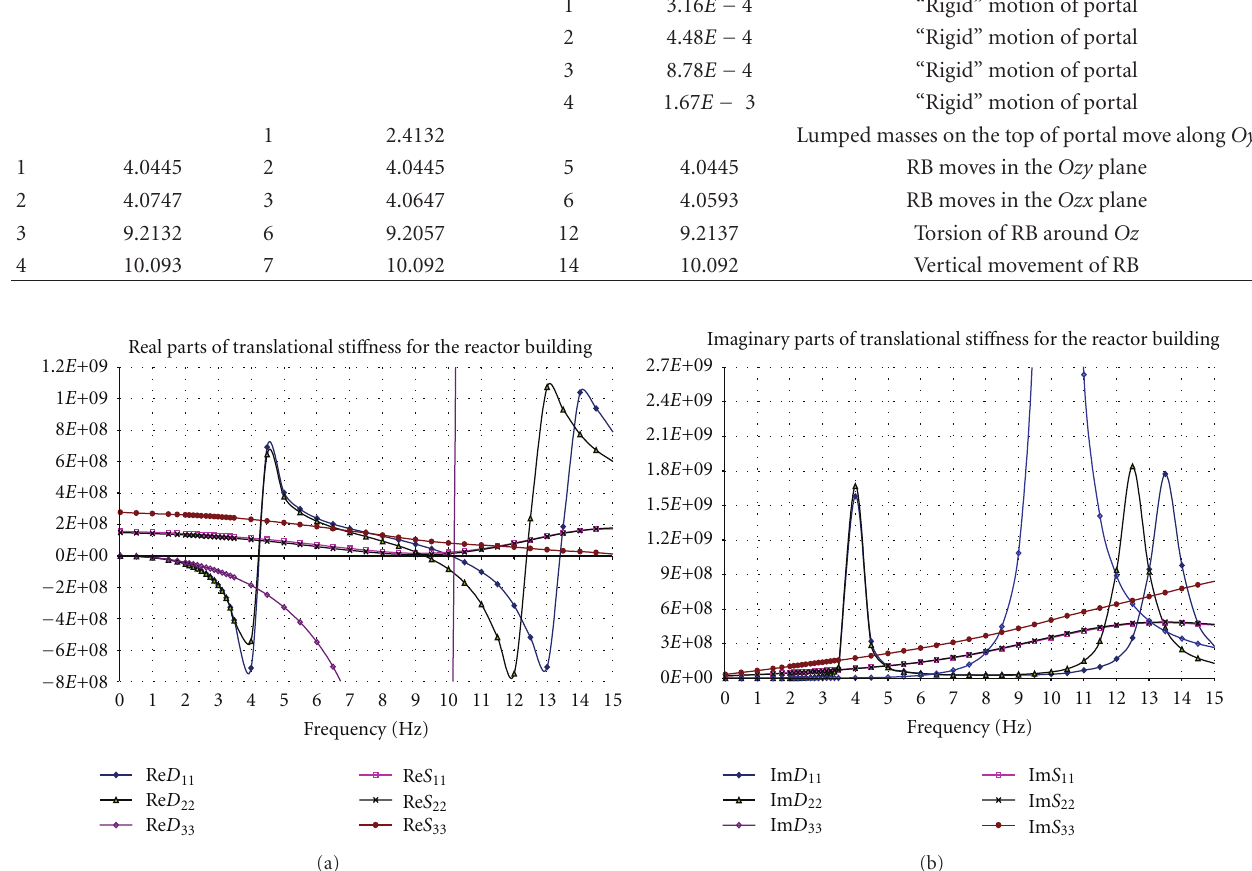
Real parts of translational sti ff ness for the portal